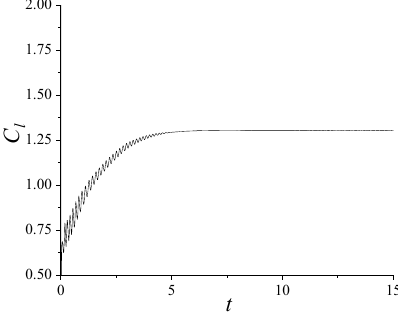
Figure 23. Lift curve of the hydrofoil when α = 12°.